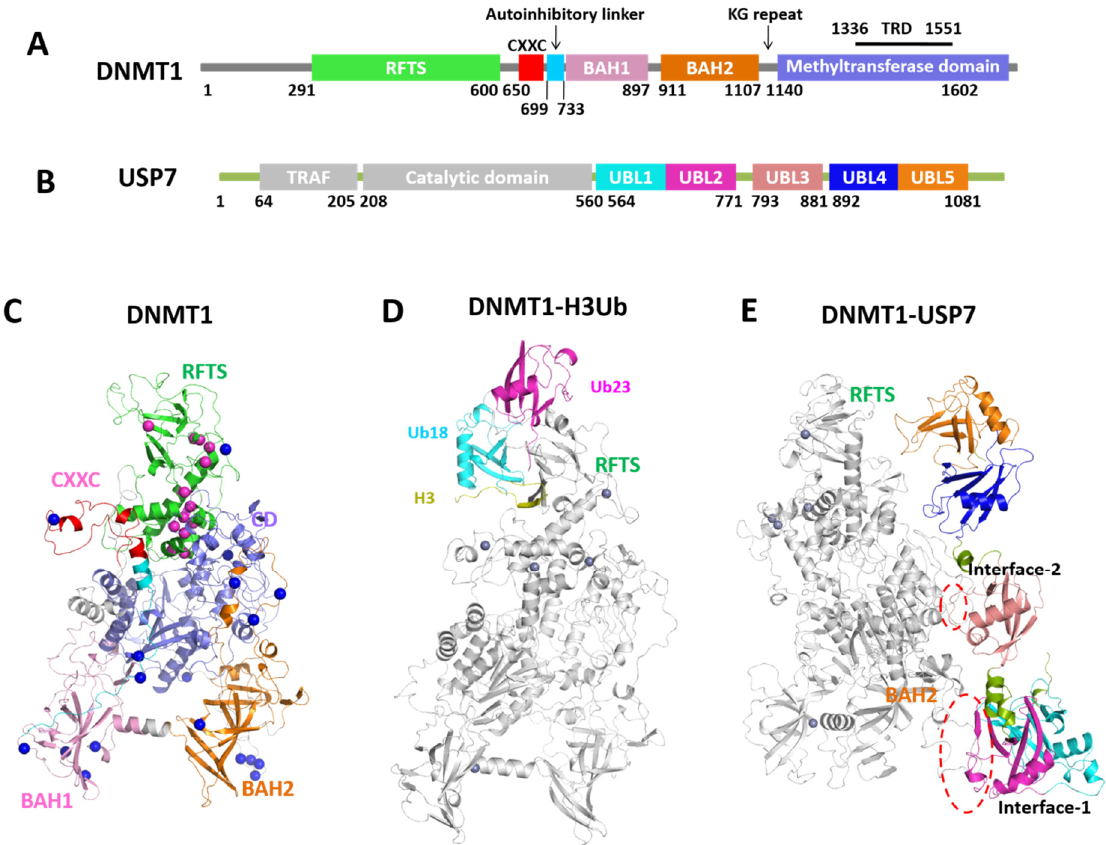
Figure 1. Structures of DNMT1 and its complexes with different partner proteins. ( A ) Color-coded domain architecture and numbering of human DNMT1 sequence. ( B ) Color-coded domain architecture and numbering of human USP7 sequence. ( C ) DNMT1 structure colored by subdomains, while disease mutations and PTM sites are denoted as magenta and blue spheres, respectively. ( D ) The constructed structures of DNMT1-H3Ub, DNMT1, Ub18, Ub23, and the H3 tail are colored grey, cyan, magenta, and yellow, respectively. ( E ) The constructed structure of DNMT1-USP7 and DNMT1 is colored grey and USP is colored by different